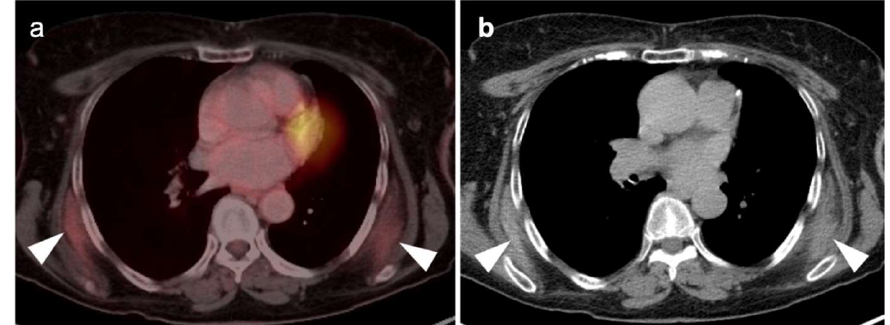
Figure 6. Elastofibroma dorsi: ( a ) Fused axial FDG PET-CT and ( b ) axial chest CT demonstrate mildly hypermetabolic diffuse soft tissue density between the latissimus dorsi and serratus muscles bilaterally ( white arrowheads ) consistent with elastofibroma dorsi.